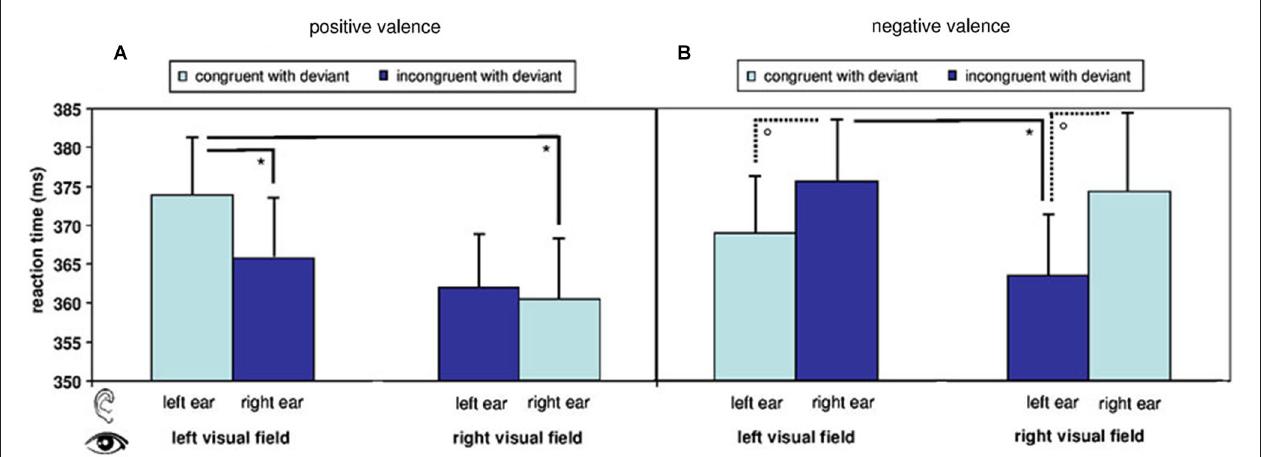
to presentation side. Postdoc T -tests further illustrate the findings: (A) Reaction times to visual stimuli in the right visual field were faster than to those in the left visual field in the positive congruent condition and (B) in the negative incongruent conditions. ( ◦ : p < 0.1; *: p (uncorr.) < 0.05; breakmean ±